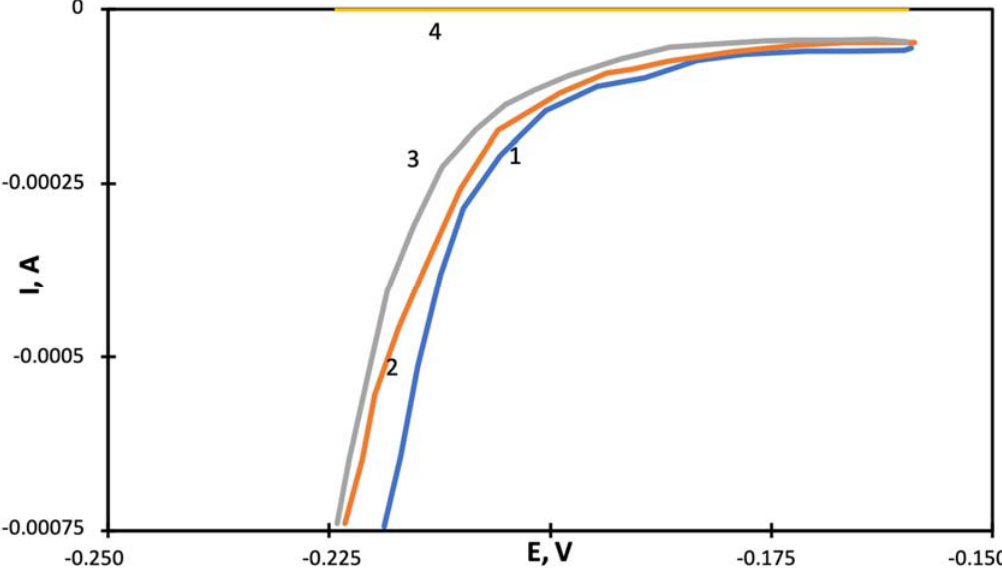
Figure 7. Polarization curves for smooth titanium electrodes with platinum coating obtained in the DC sputtering regime recorded in an aqueous solution of 1 M of sulfuric acid in the potential region from − 0.25 V to − 0.15 V at temperature of 25 °C (scan rate 0.1 mV/s). Curve 1—Pt ‐ C target was sputtered; curve 2—Pt target was sputtered. Curves 3 for platinum foil and curve 4 for smooth titanium are given for comparison.